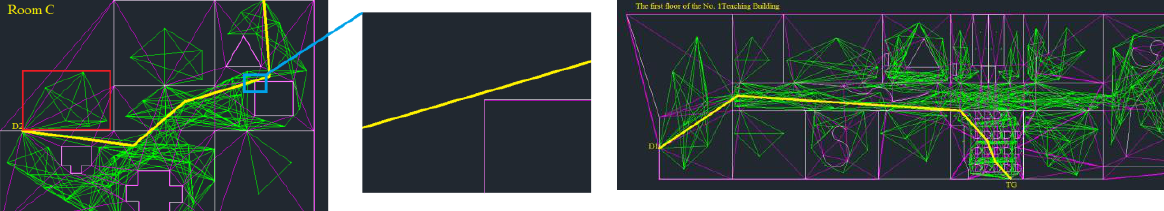
Figure 16. Resulting network for navigation (green) and the shortest path (bold